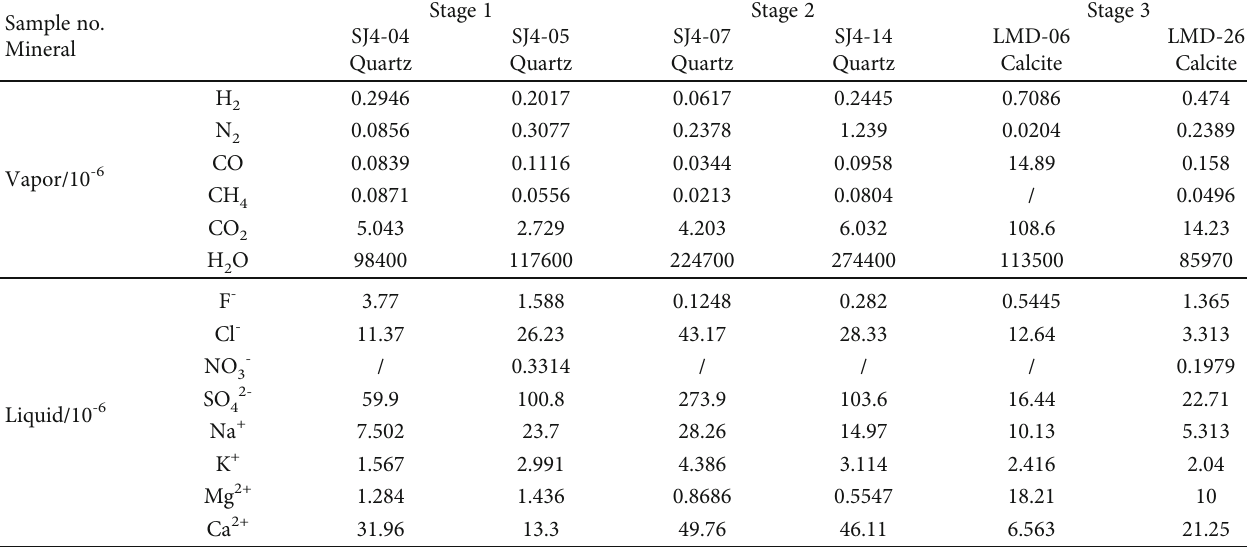
-6 ) from the Longmendian deposit. B /10